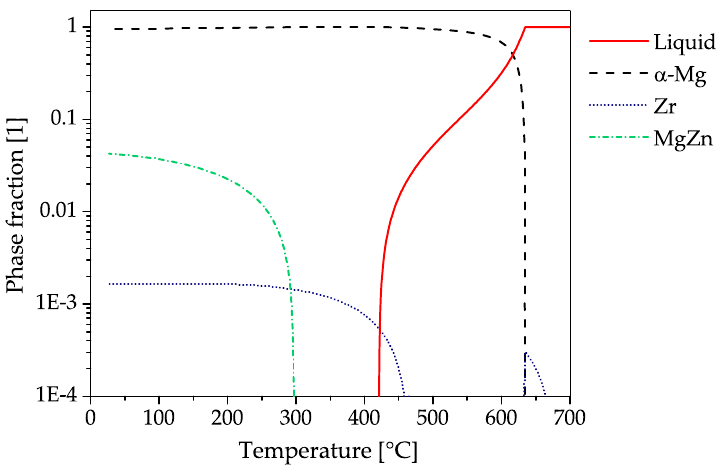
Figure 22. CALPHAD calculations (for further information see Appendix A) of ZK60 in a temperature range of 25 to 700 ◦ C, showing phase fractions of 10 − 4 to